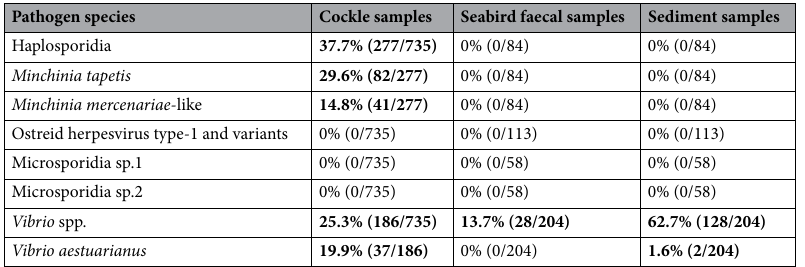
Table 2. Total numbers of positive cases (%, positive individuals/screened individuals) for the screening done for the target pathogen species in cockles, seabird faecal samples and sediment samples.